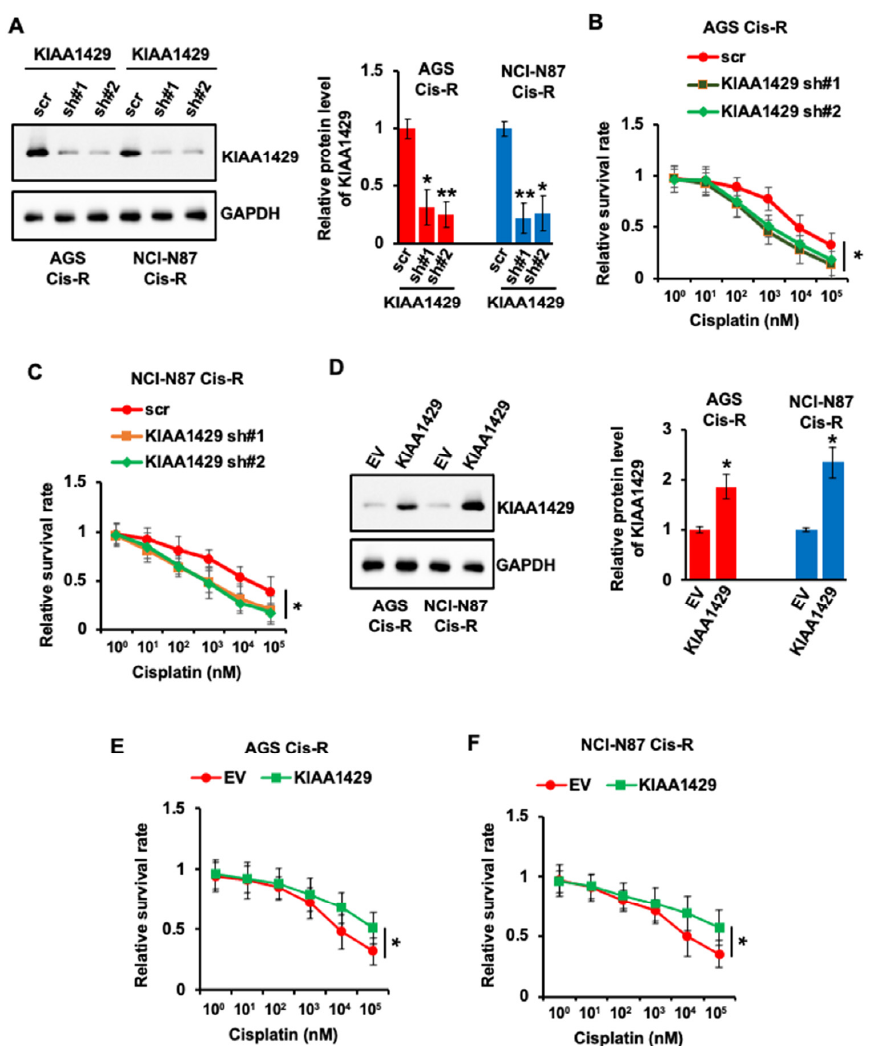
Figure 2. Effect of KIAA1429 depletion or overexpression on cisplatin resistance in gastric cancer cells. ( A ) AGS Cis-R or NCI-N87 Cis-R cells were infected with KIAA1429 shRNA, and the protein level of KIAA1429 was assessed by Western blotting and densitometric quantification. ( B , C ) Cisplatin IC50 experiment was performed in AGS Cis-R ( B ) or NCI-N87 Cis-R ( C ) cells after infected with KIAA1429 shRNA. ( D ) AGS Cis-R or NCI-N87 Cis-R cells were transfected with KIAA1429 plasmid, and the protein level of KIAA1429 was assessed by Western blotting and densitometric quantification. ( E , F ) Cisplatin IC50 experiment was performed in AGS Cis-R ( E ) or NCI-N87 Cis-R (FC) cells after transfected with KIAA1429 plasmid. * p < 0.05, ** p <